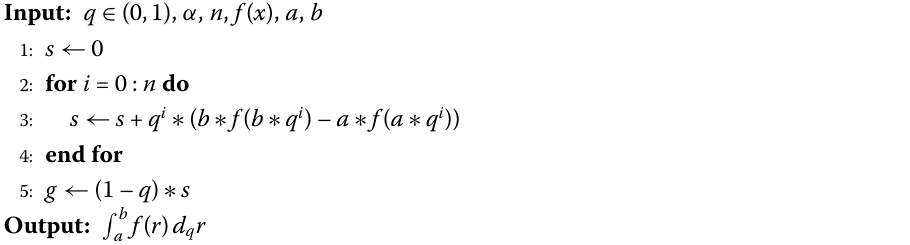
Algorithm 4 The proposed method for calculation